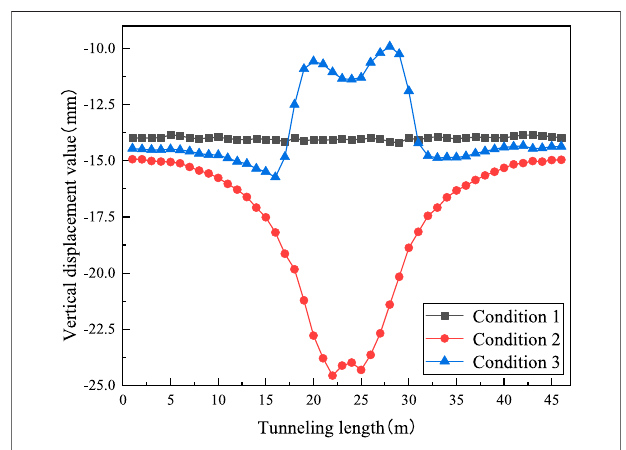
FIGURE 14 | Vertical deformation curve of the arch under different